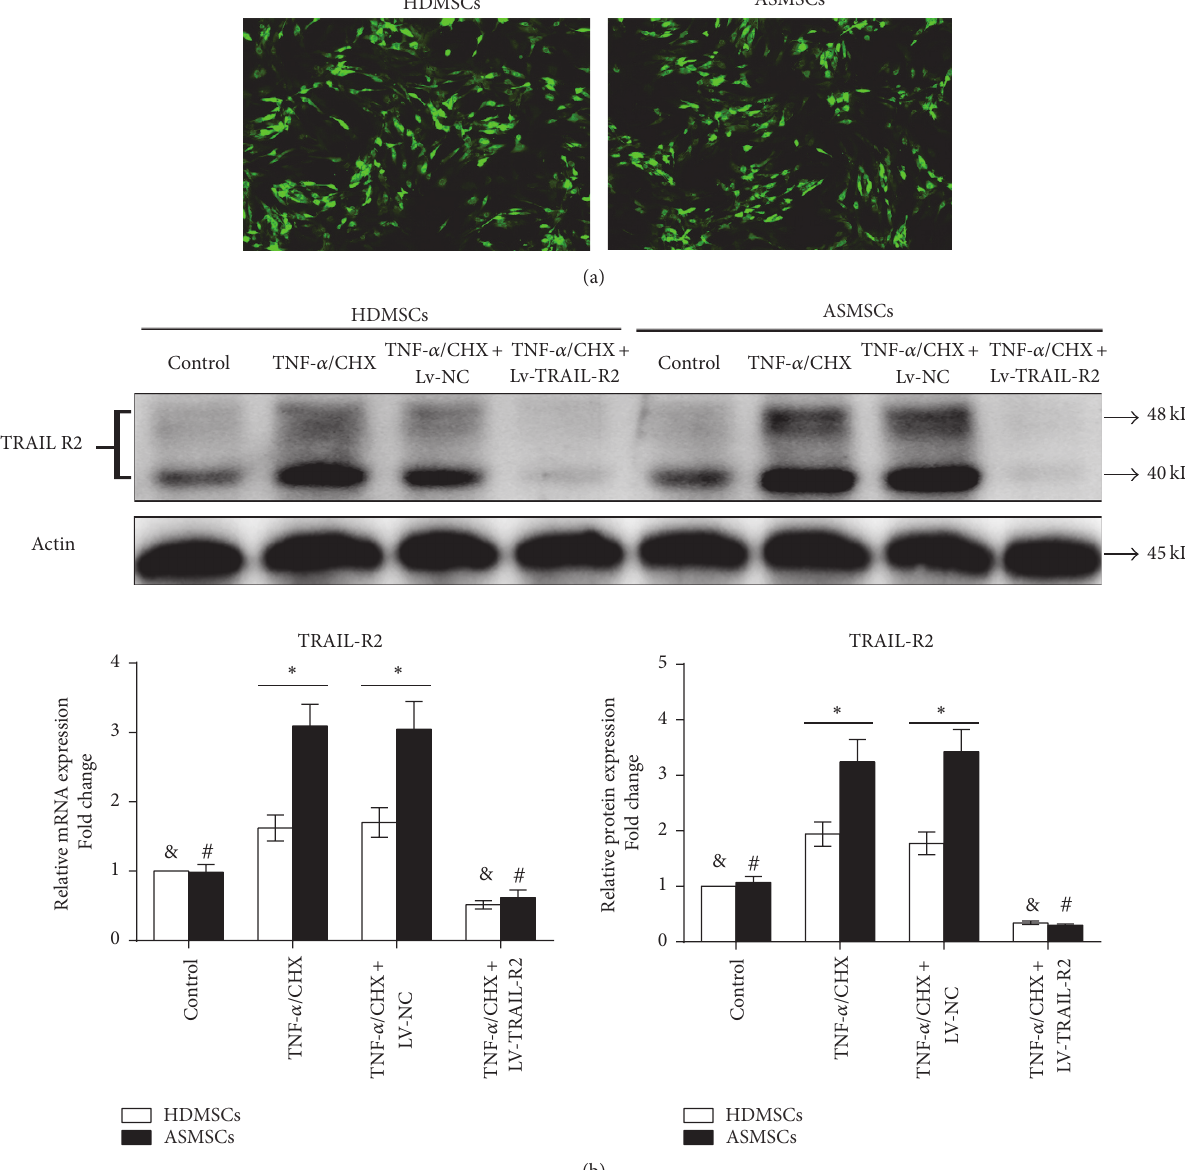
Figure 5: The transduction efficiencies of lentiviruses encoding shRNA-TRAIL-R2 were comparable in HDMSCs and ASMSCs. (a) GFP- positive cells were observed under a confocal microscope (40x), and the transduction efficiencies were comparable between HDMSCs and ASMSCs. (b) The lentiviruses encoding shRNA-TRAIL-R2 inhibited both the gene and protein expression of TRAIL-R2 in HDMSCs ( 𝑛 = 28 ) and ASMSCs ( 𝑛 = 22 ). Values are presented as the mean ± SD. ∗ indicates 𝑃 < 0.05 between HDMSCs and ASMSCs. & indicates 𝑃 < 0.05 for theTNF- 𝛼 /CHXgroup compared withother HDMSCsgroups. # indicates 𝑃 < 0.05 fortheTNF- 𝛼 /CHXgroup compared with otherASMSCs groups. Lv-NC refers to MSCs transduced by lentiviruses encoding a negative control sequence. Lv-TRAIL-R2 refers to MSCs transduced by lentiviruses encoding